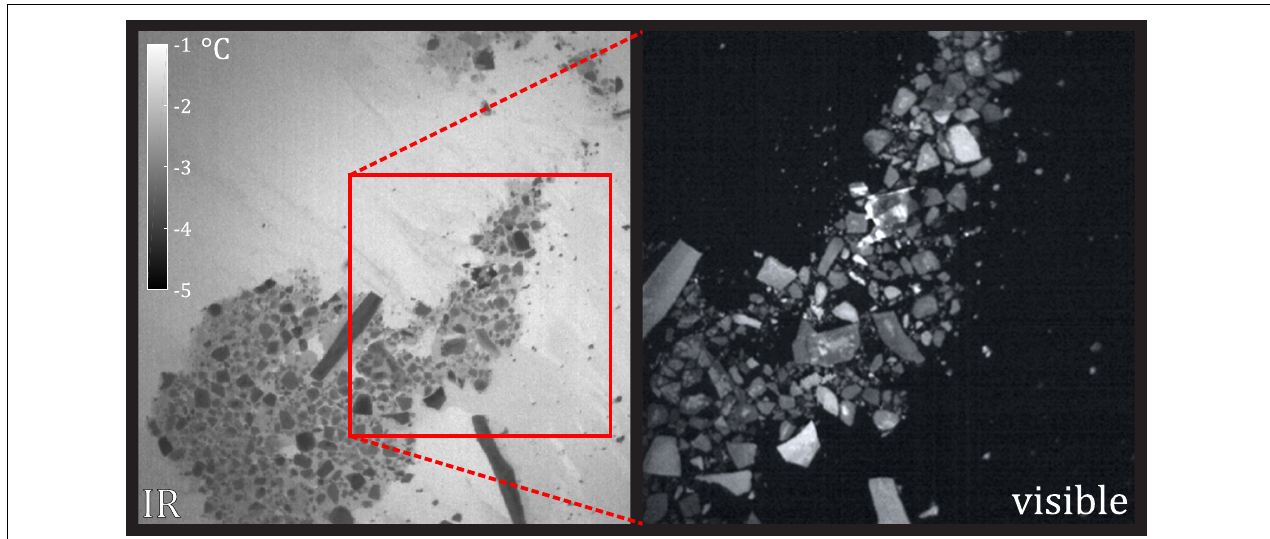
FIGURE 6 | Imagery of fjord water with loose sea ice obtained from Manta equipped with the ATOM payload. The thermal image in the left panel was obtained from the Atom microbolometer and the visible image in the right panel was obtained from the Flare camera.